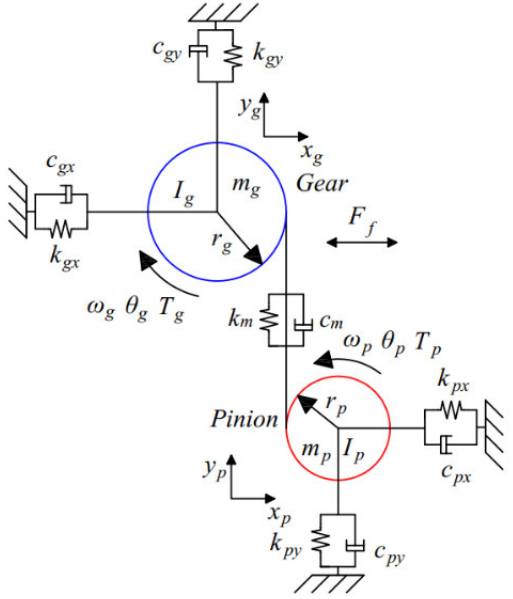
Figure 9. Dynamic model of the spur gear transmission system.